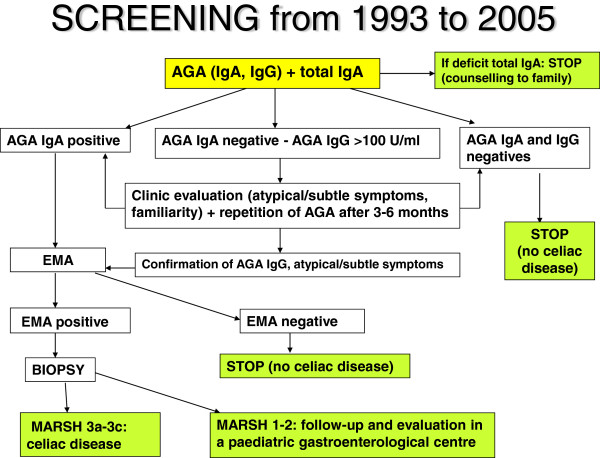
“Screening from 1993 to 2005”.